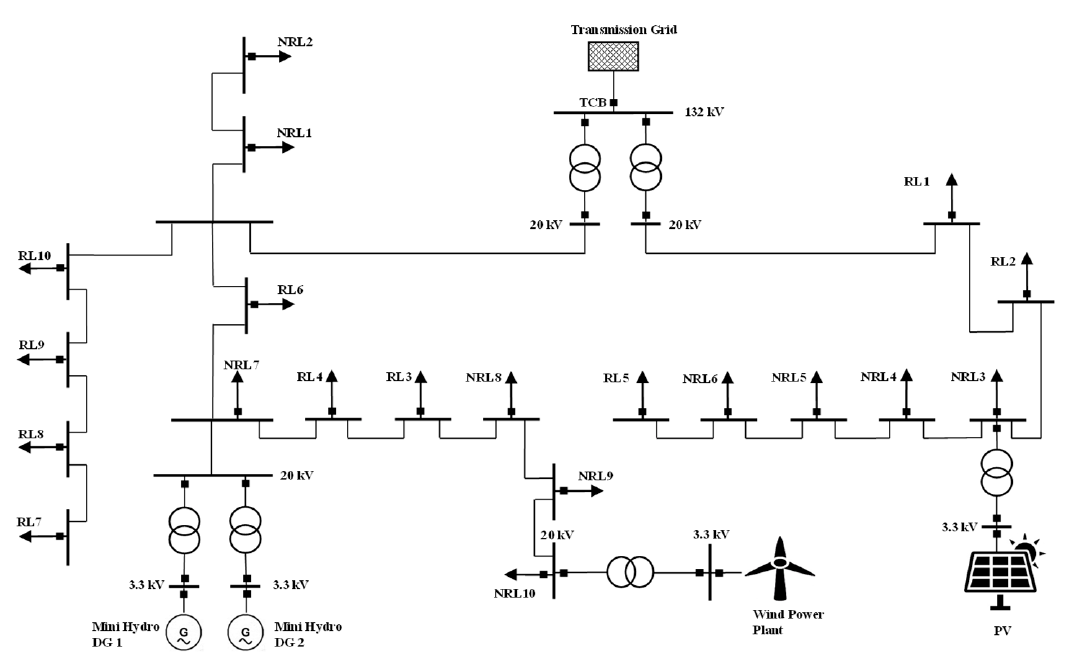
Figure 8. The 20 kV distribution test network.